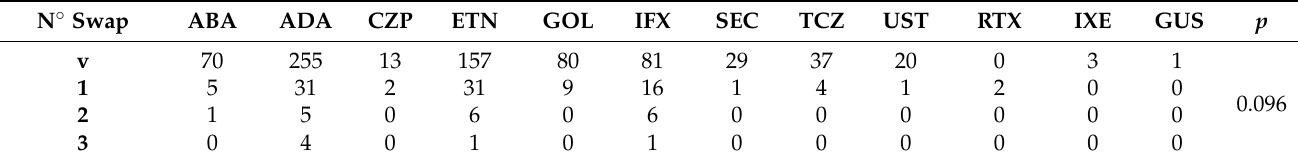
Table 5. No. of swaps among